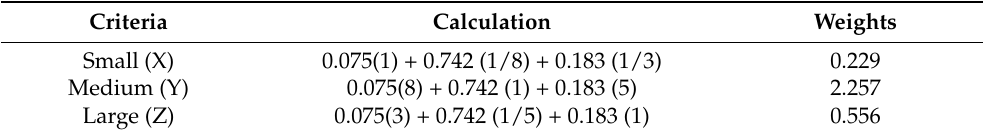
Table 18. The weights